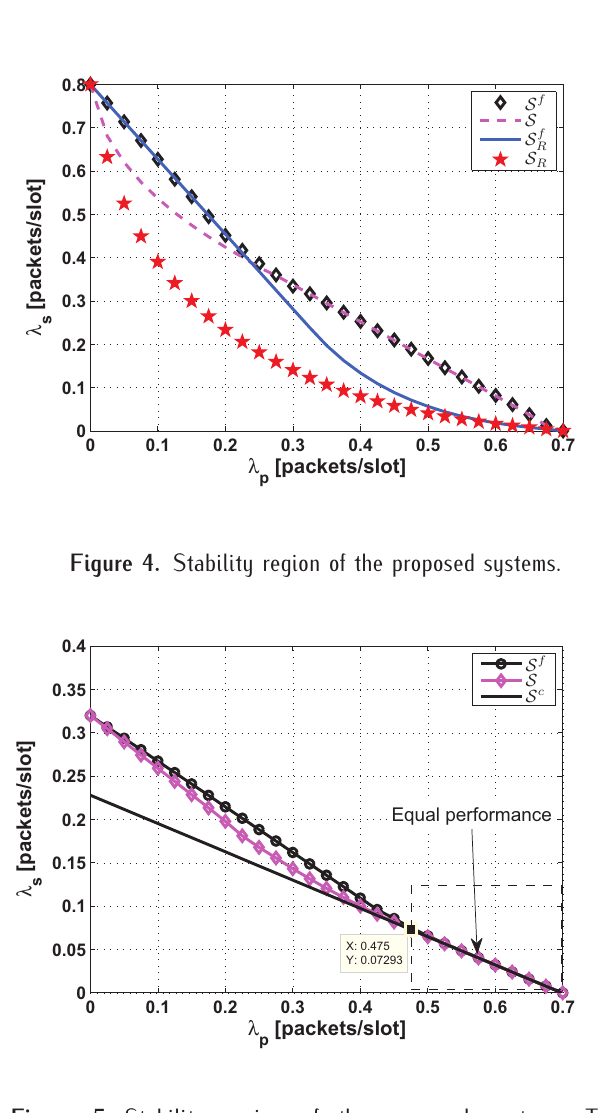
Figure 5. Stability region of the proposed systems. The conventional system, S c , is also plotted for comparison purposes.